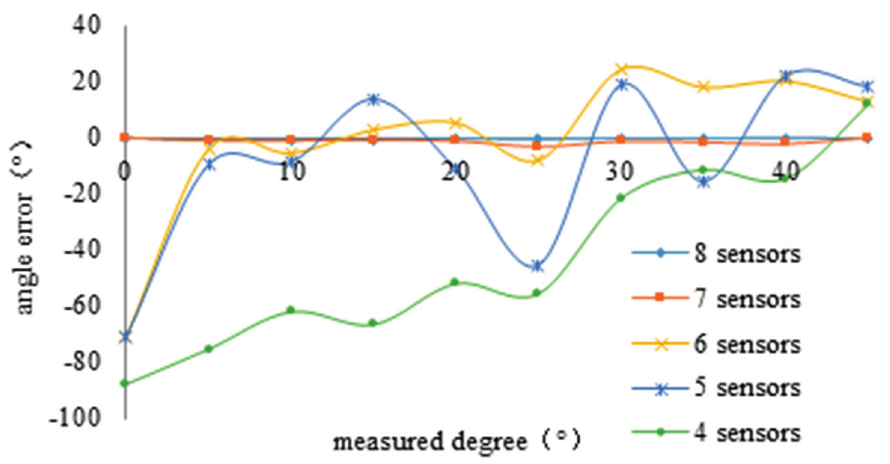
Figure 8. Relationship between number of sensors and accuracy.